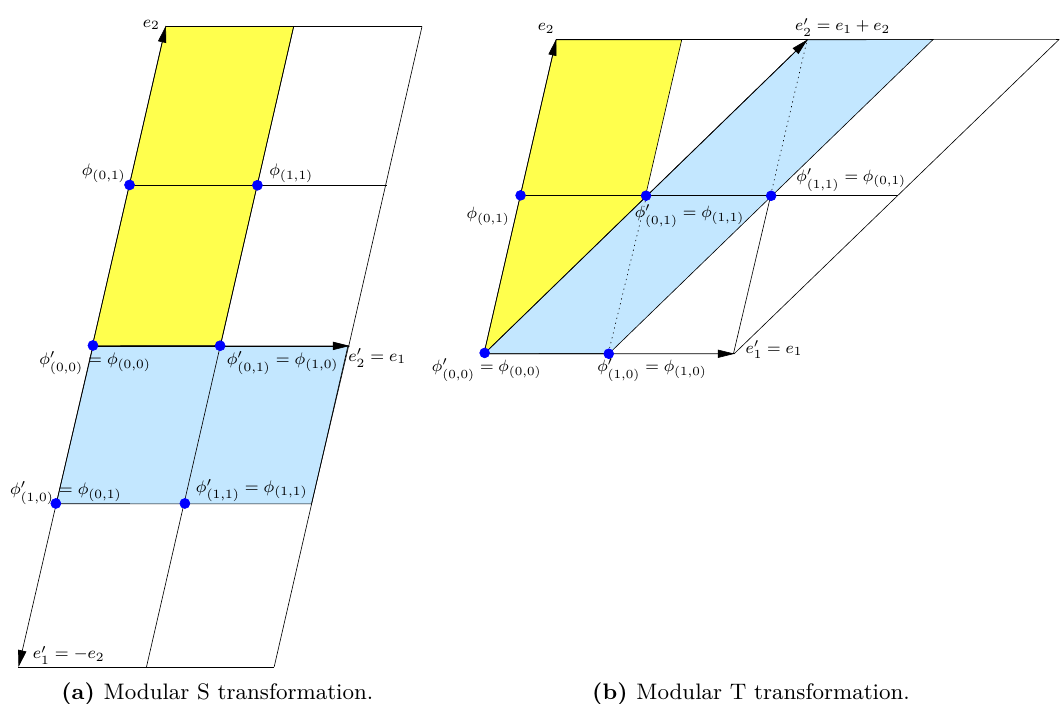
Figure 3 . The action of the SL(2 , Z ) U generators ˆ C S (a) and ˆ C T (b) associated with the complex structure modulus U on the T 2 / Z 2 orbifold. From the action of the SL(2 , Z ) U generators on the T 2 basis, eq. (3.3), the original (yellow) fundamental domain of the orbifold is mapped to an equivalent but different (blue) region. Hence, twisted matter fields φ eqs. (3.4) and